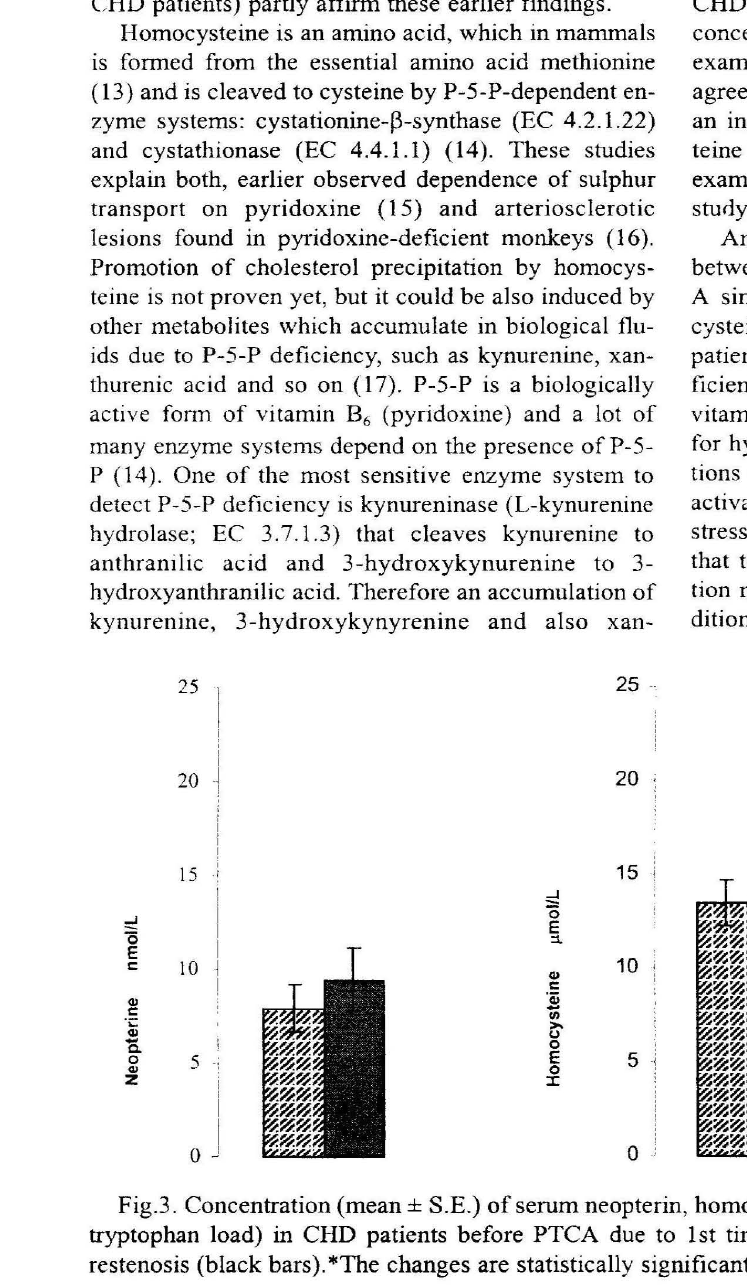
PteridineslVol. 12/No.